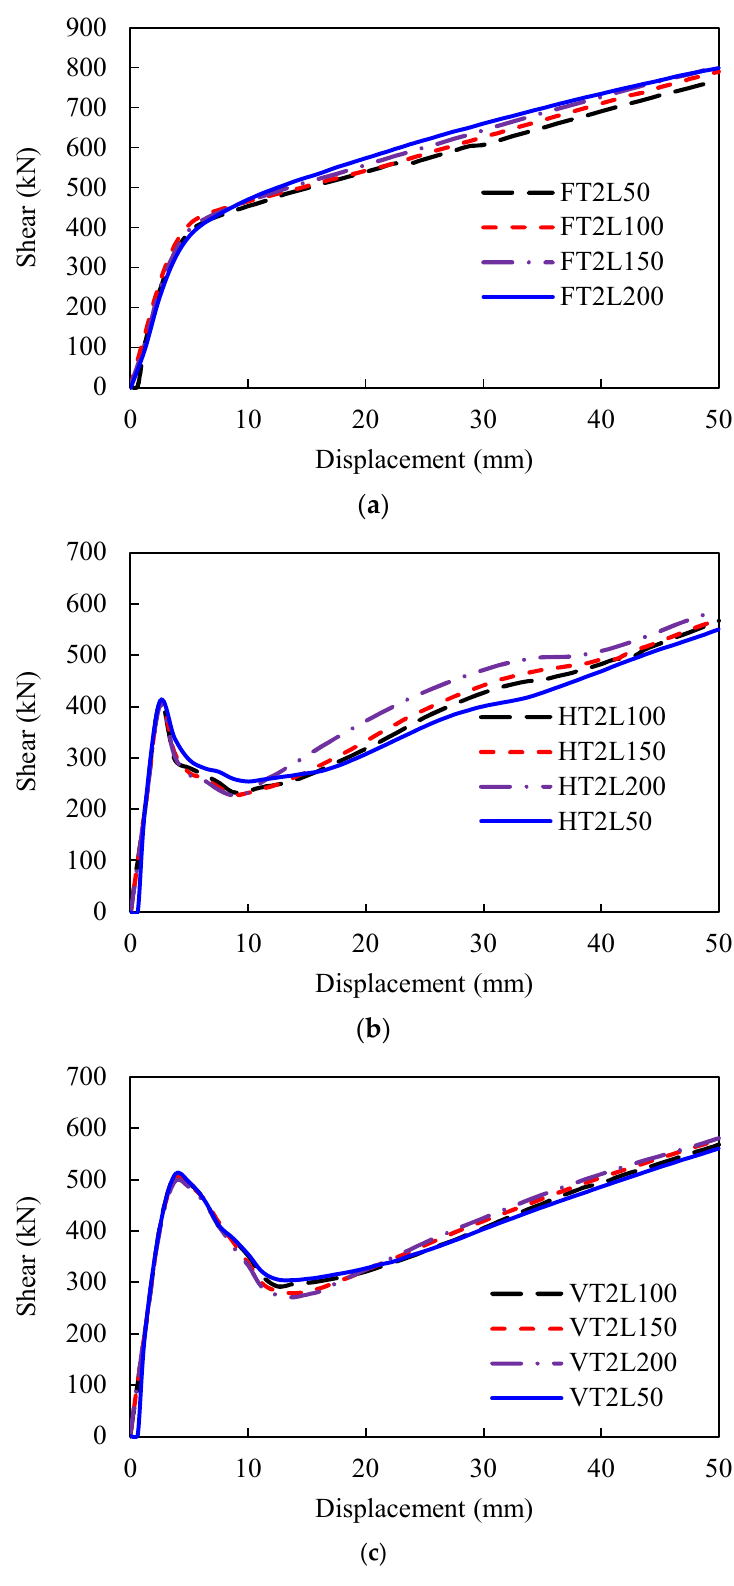
Figure 13. Effect of vertical load on the SPSWs with a thickness of 2 mm and a ( a ) flat, ( b ) horizontal corrugated, and ( c ) vertical corrugated plates.